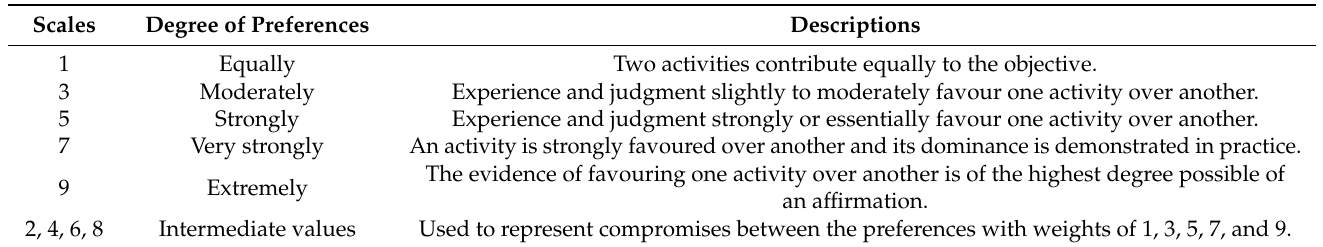
Table 1. Saaty rating scales for criterion weights and ranks